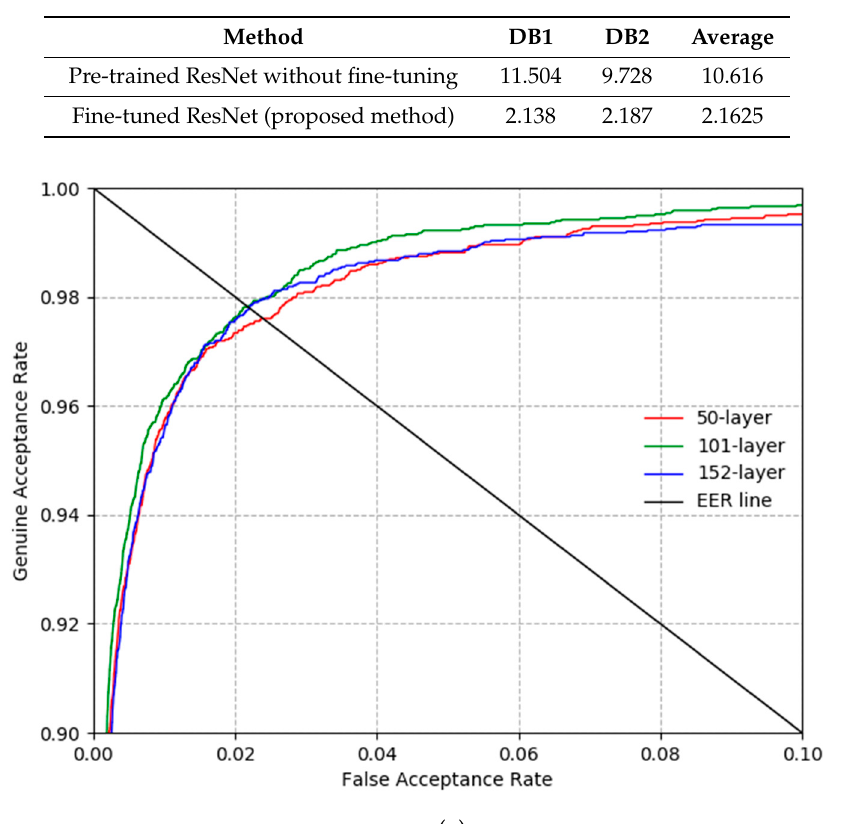
Table 4. Comparative EERs with each dataset by various ResNet architectures (unit: %). ResNet model